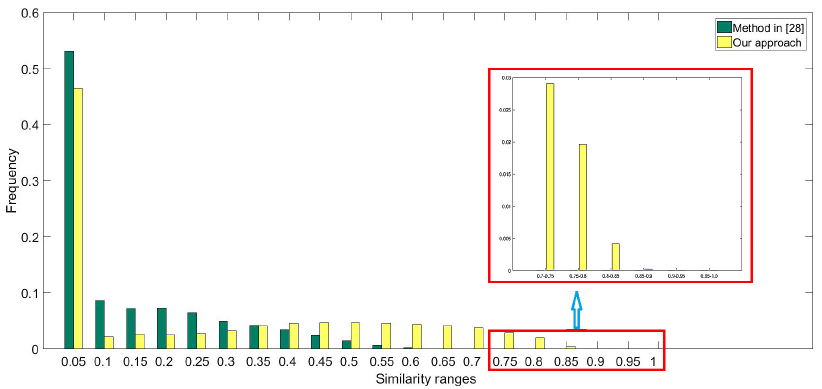
Figure 20. Comparison chart of the similarity histograms for reference scene